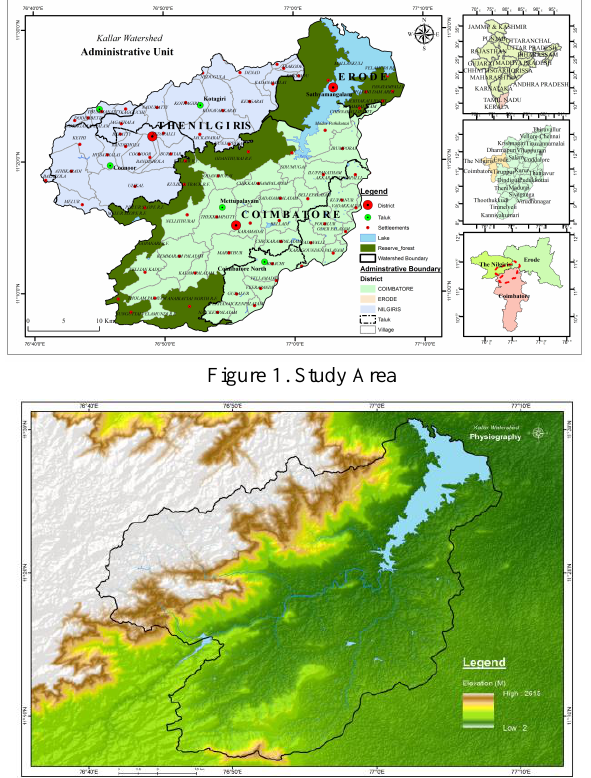
Figure 2. Physiography